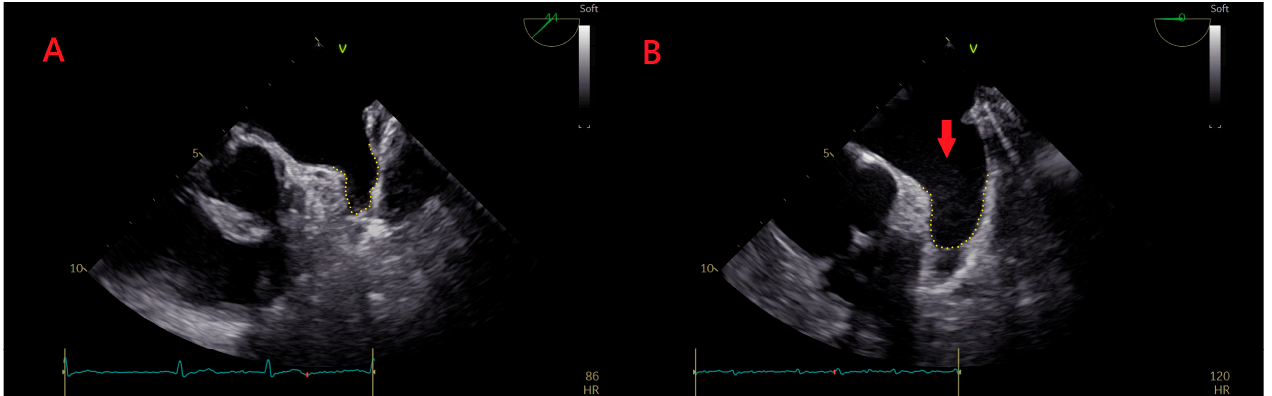
Figure 1. Representative echocardiogram of LASEC. ( A ) No LASEC was detected by TEE. ( B ) LASEC (arrow) was revealed by TEE. V stands for left side, numbers 0 and 44 stand for imaging plane angle.